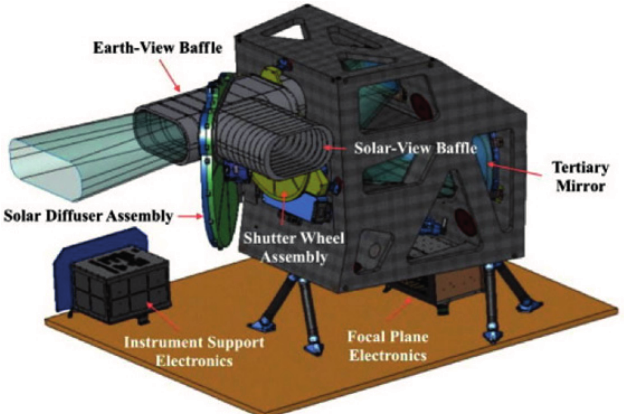
Figure 1. Schematic of Landsat 8 OLI